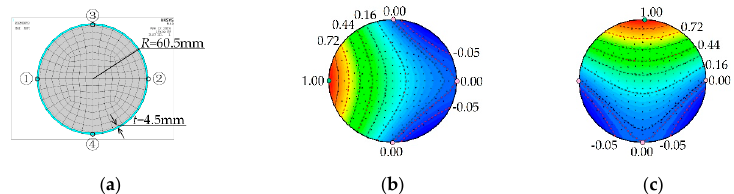
Figure 8. The finite element (FE) model of the cross-section and contour maps of numerical shape functions: ( a ) FE model; ( b ) discrete weighting function N 1 ; ( c ) discrete weighting function N 3 .